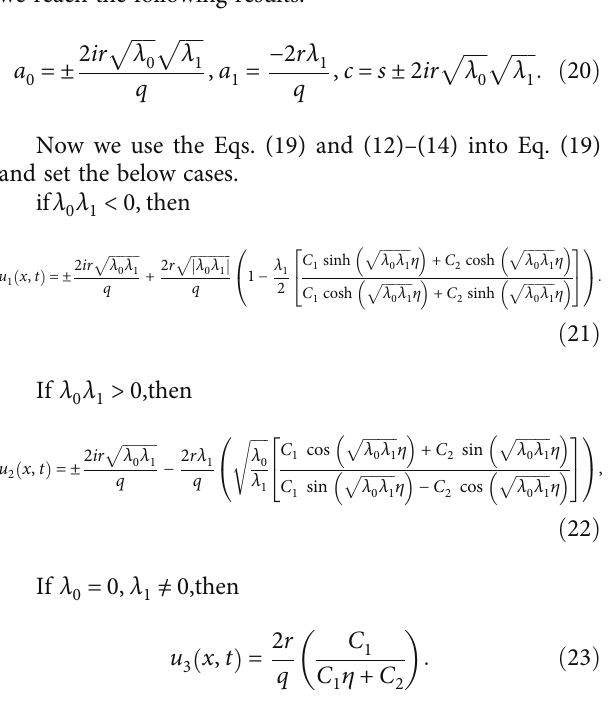
ffiffiffiffiffi p λ : ð 20 Þ 1